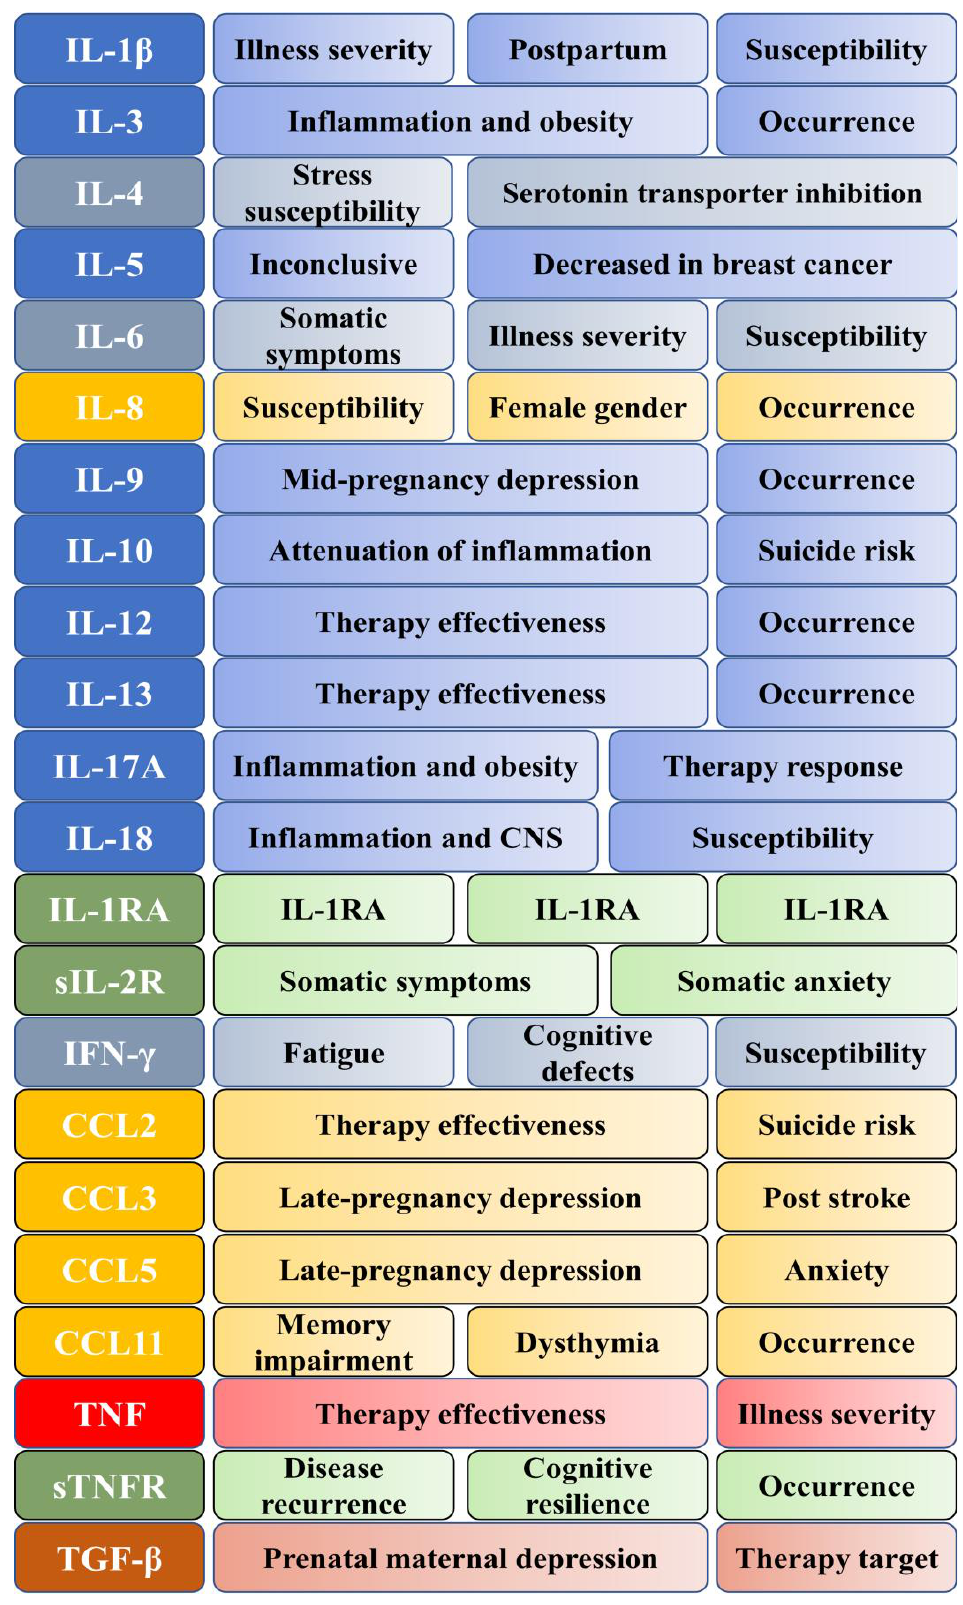
Figure 1. Cytokines and their main associations with depression. Blue — interleukins, gray — lymphokines, yellow — chemokines, green — soluble receptors, red — tumor necrosis factor, brown — transforming growth factor .